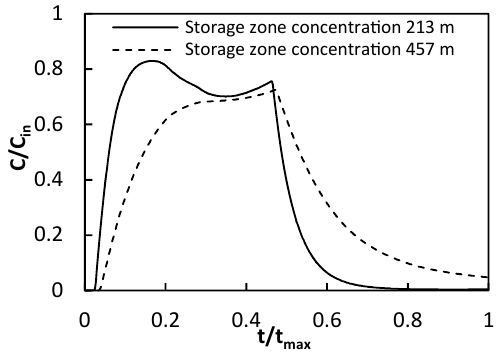
Figure 21. Simulated storage zone concentrations (test case